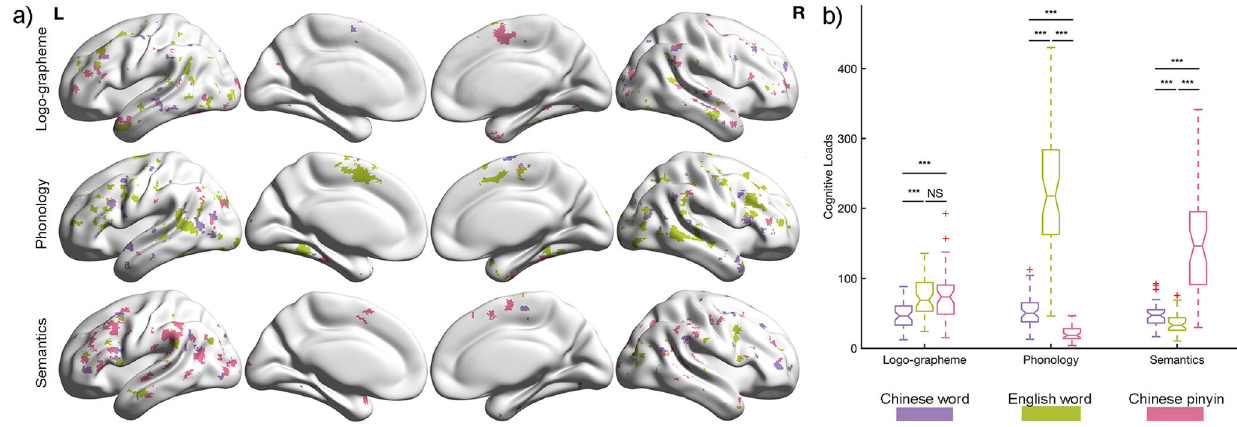
Fig. 3 Brain responses to linguistic component for three language types. a Brain involvement maps of 3 reading systems for each linguistic component. Purple indicates brain activations elicited by Chinese word, pistachio green represents English word and magenta denotes Chinese pinyin. Gray lines indicate the regional boundaries. b Comparisons in the cognitive loads between language types and linguistic components. Two-way repeated ANOVA was performed, and signi fi cant interactions were found between linguistic components and language types. Post hoc analysis shows differentiated patterns